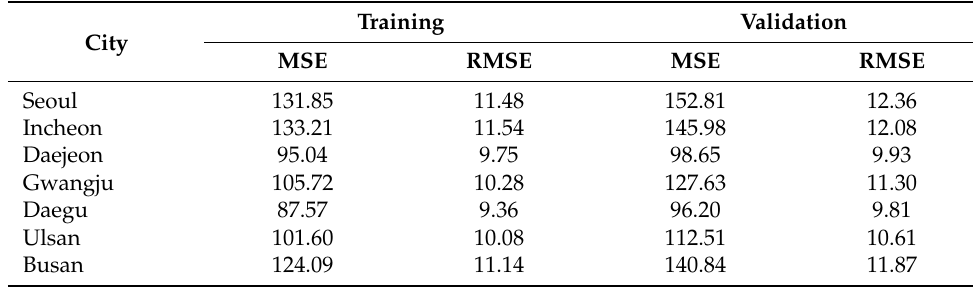
Table 4. Evaluation of the suitability of model optimization